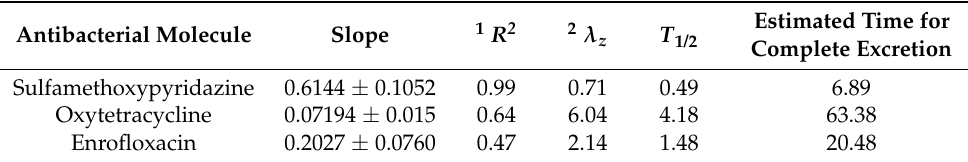
Table 1. Half-lives of elimination ( T 1/2 ) calculated using Equation (1) and estimated times for the complete removal from urine determined for sulfamethoxypyridazine, oxytetracycline, and enrofloxacin expressed in days.